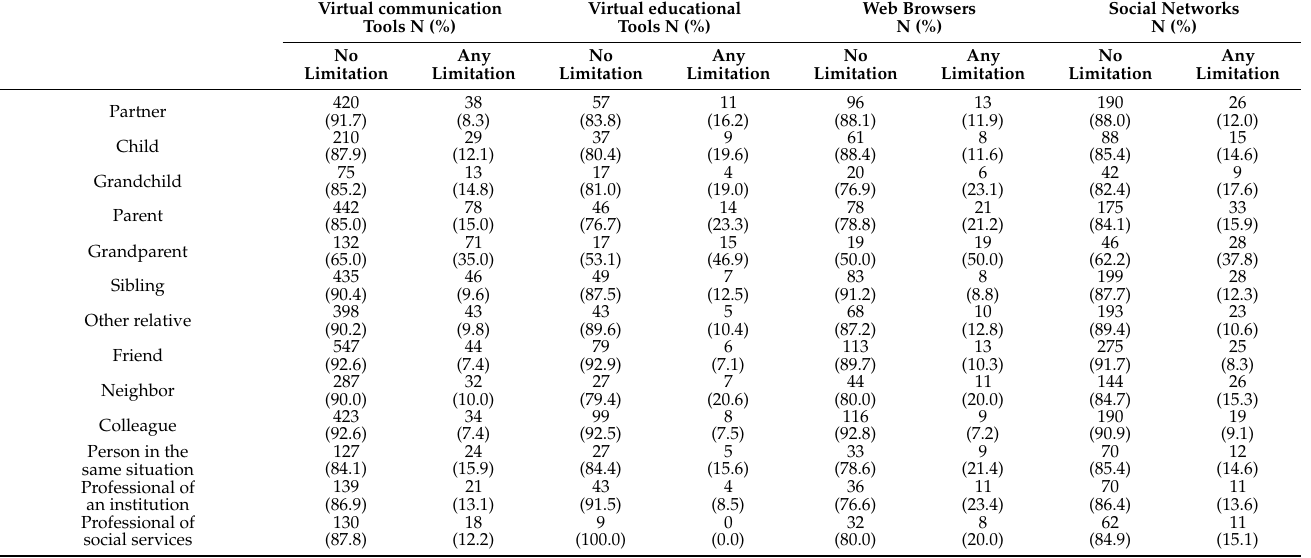
Table 6. Limitations of people with whom participants performed intergenerational virtual